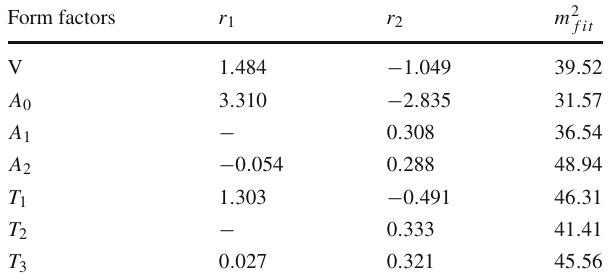
Table 7 Form factors for B → ϕ l 1 l